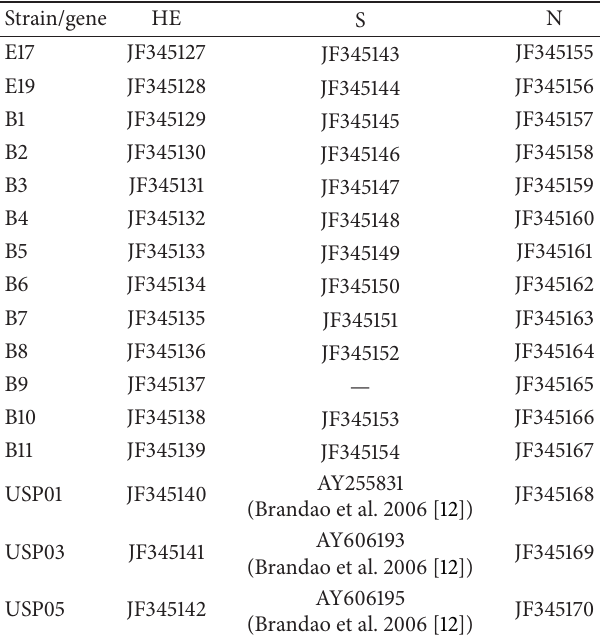
Table 1: GenBank accession numbers of the strains studied; (—) not